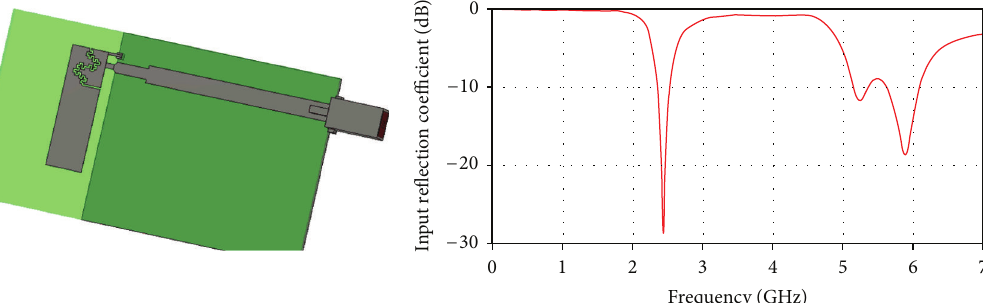
Figure 12: The computational model of the dual-band MK2 PIFA in perspective and the magnitude of its input reflection coefficient in the range DC-7GHz.